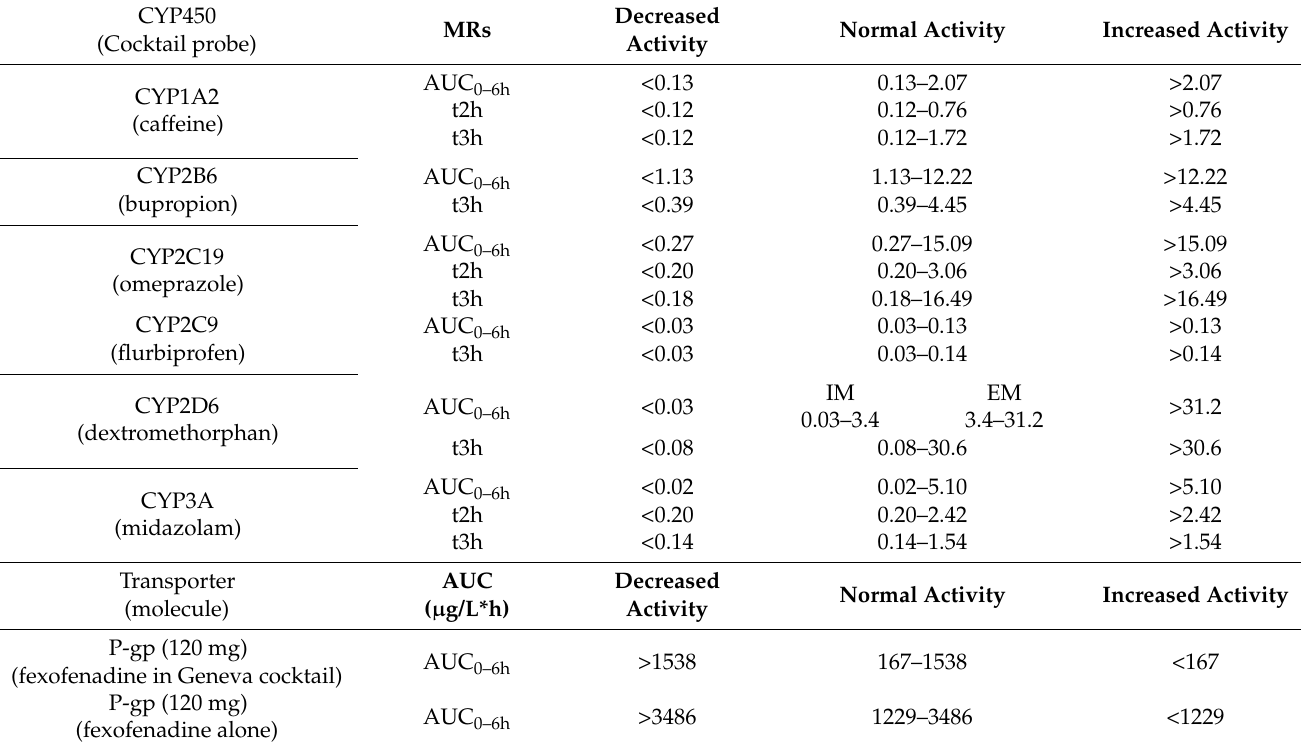
Table 1. Phenotyping indices predicted intervals for “normal” activities obtained from the literature